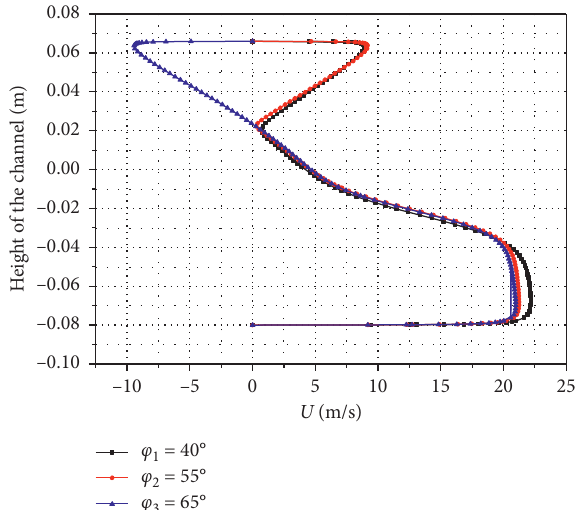
Figure 7: Axial velocity profiles downstream of the first baffle at x � 0.285m for different values of inclination angles: φ 1 � 40 ° ; φ 2 � 55 ° ; φ 3 � 65 ° .